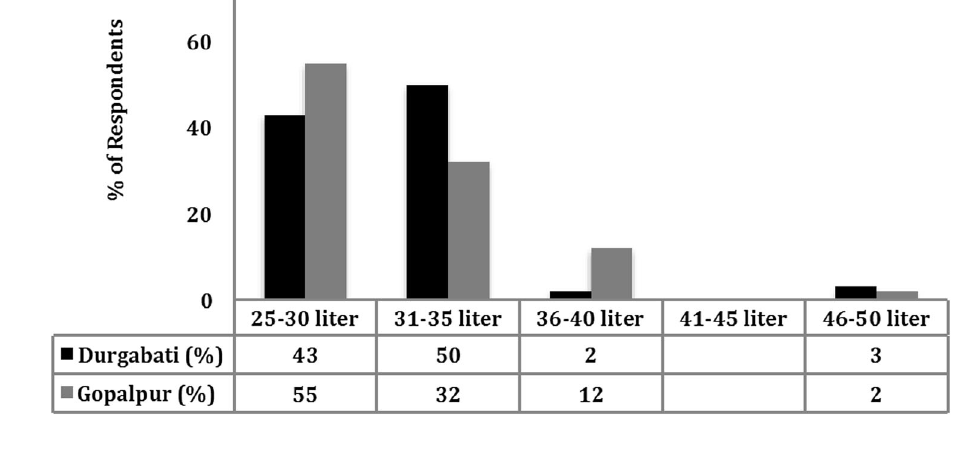
Fig. 10 Distance inhabitants